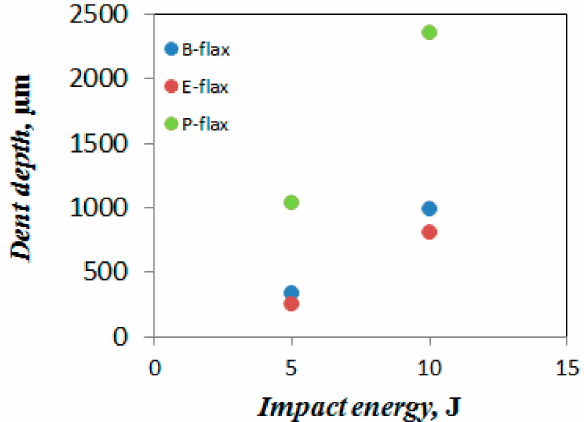
Figure 12. Comparison of the dent depth of flax tape thermoset composites after impact test with 5 and 10